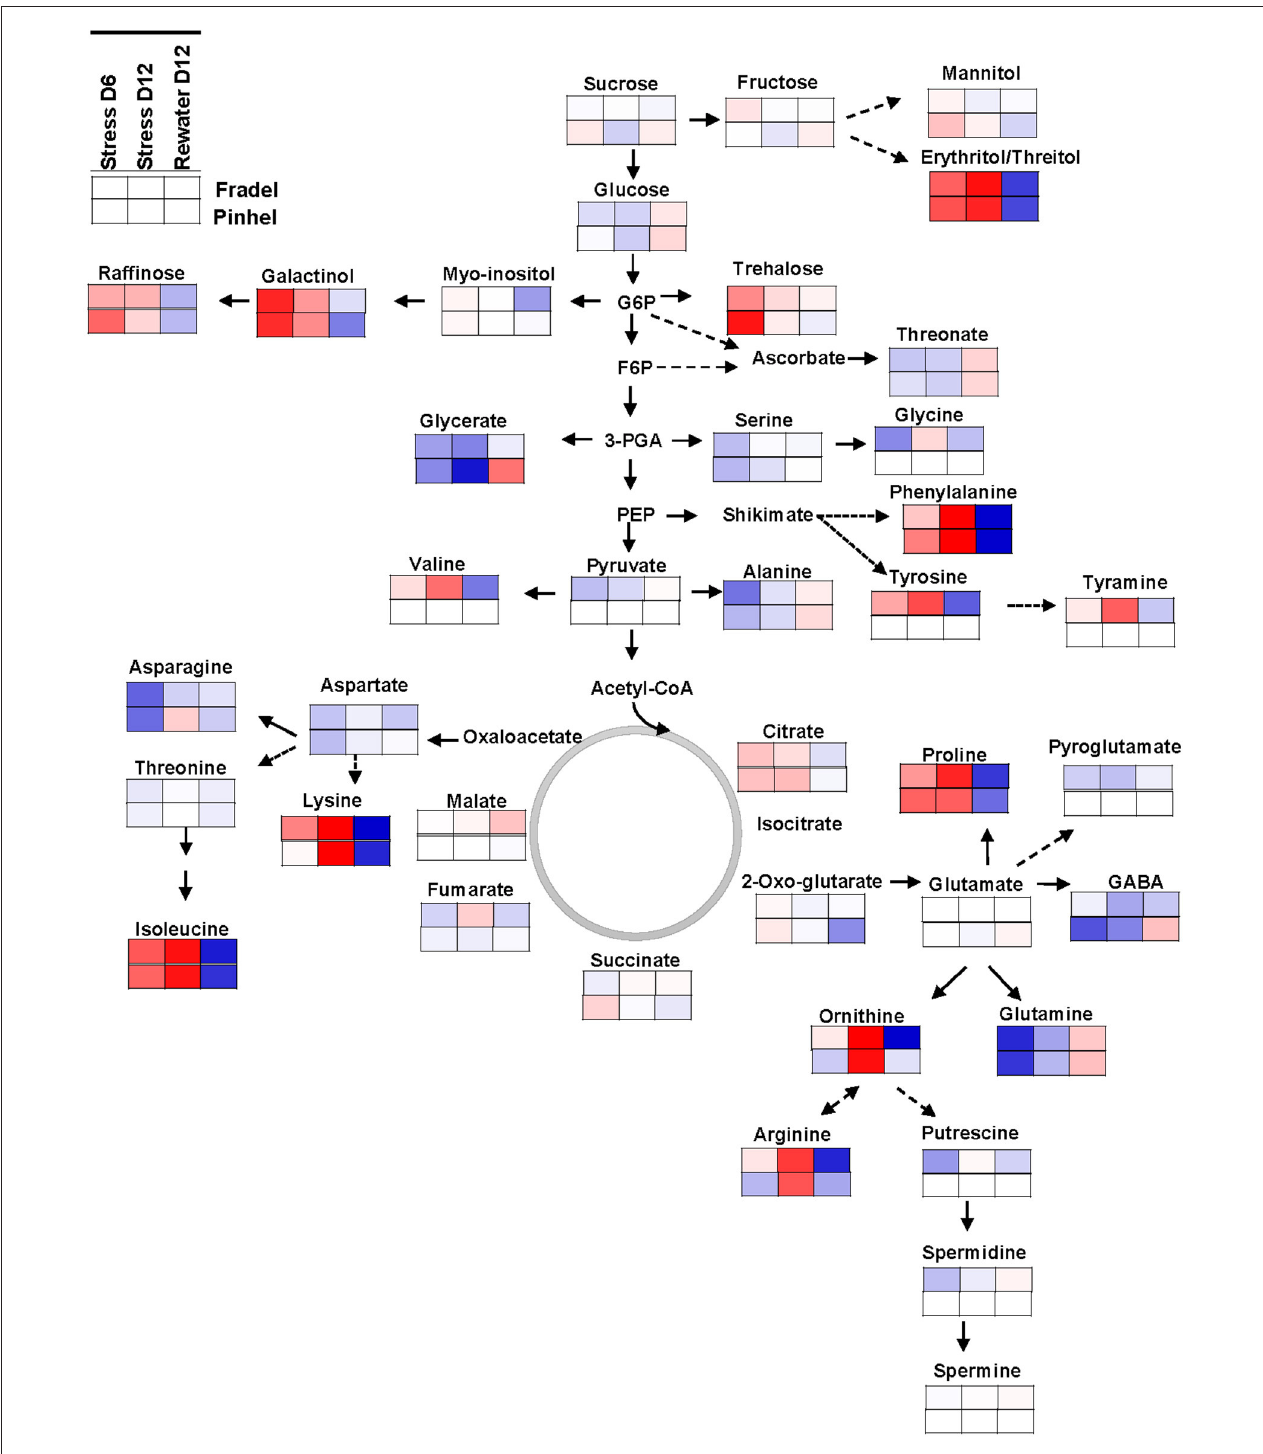
FIGURE 10 | Mapping of leaf metabolites in representative pathways. Metabolites are visualized using the averaged log fold-change ratios ( n = 4 to 6) between drought-stressed and well-watered plants harvested at day 6 and 12, and between rewatered and drought-stressed plants harvested at day 12. Fradel = top row cells; Pinhel = bottom row cells. Red and blue indicate increased and decreased levels,